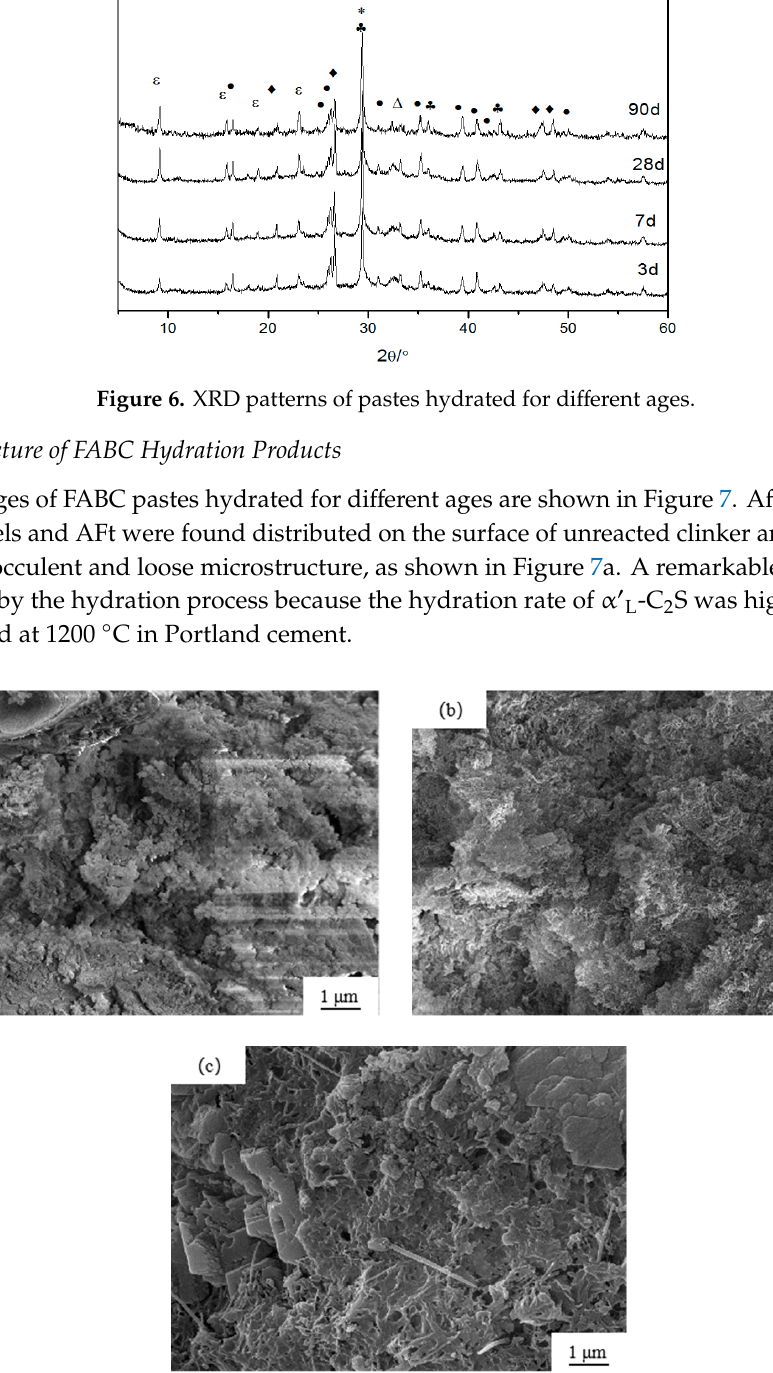
Figure 7. SEM images of pastes hydrated for di ff erent ages: ( a ) 3 days; ( b ) 28 days; ( c ) 90 days.